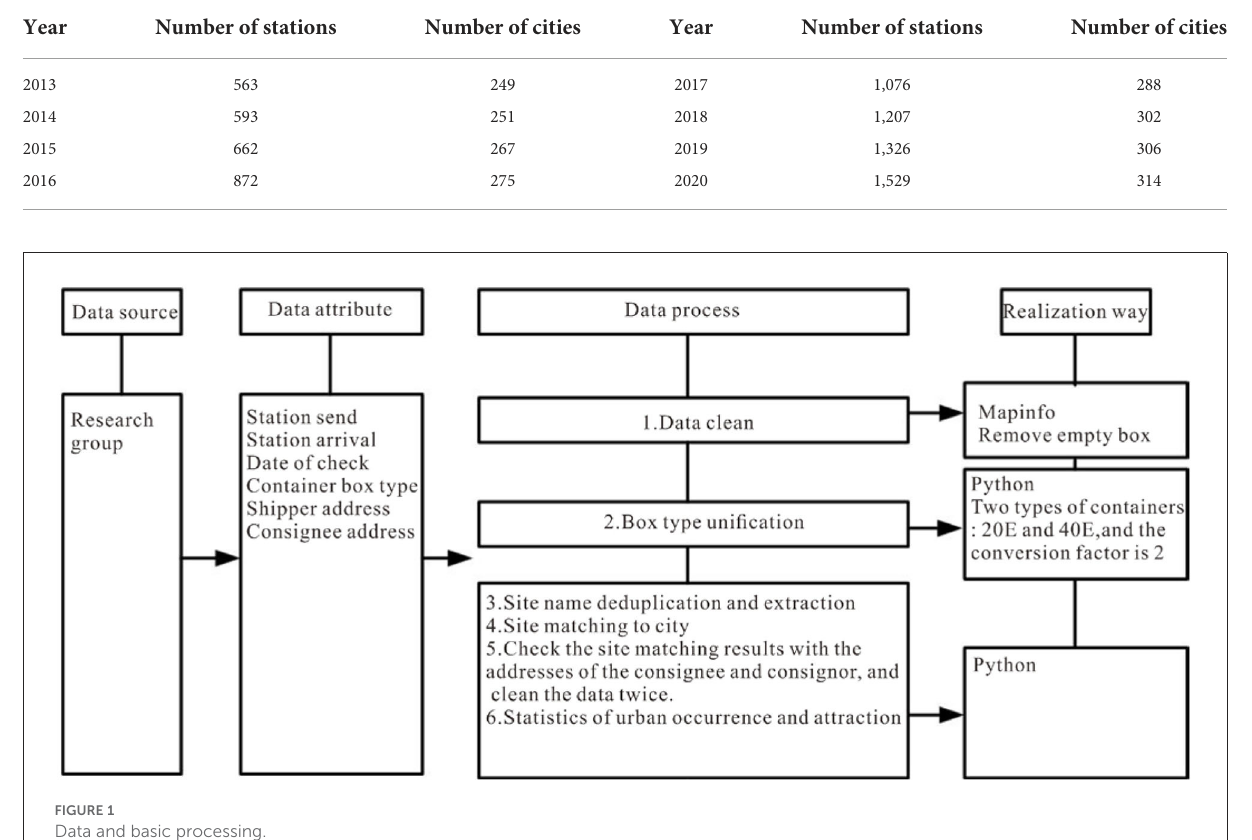
FIGURE1 Data and basic